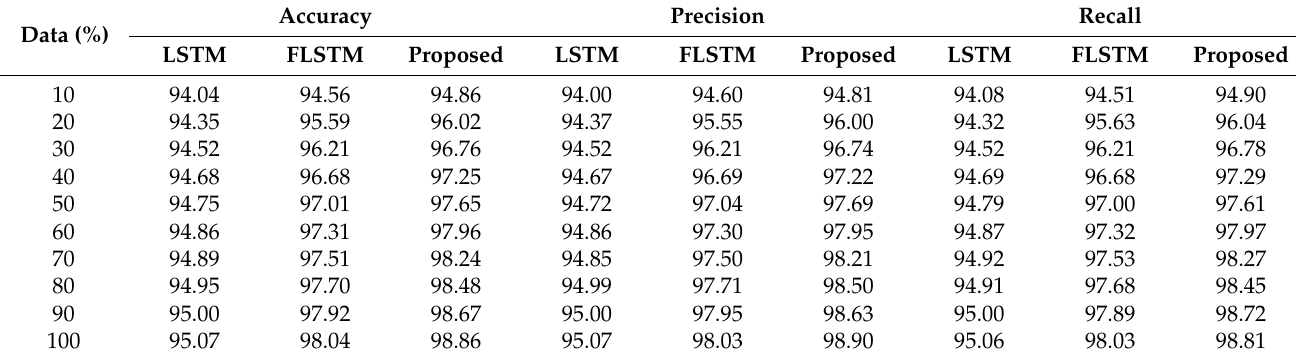
Table 4. Performance measures of accuracy, precision, and